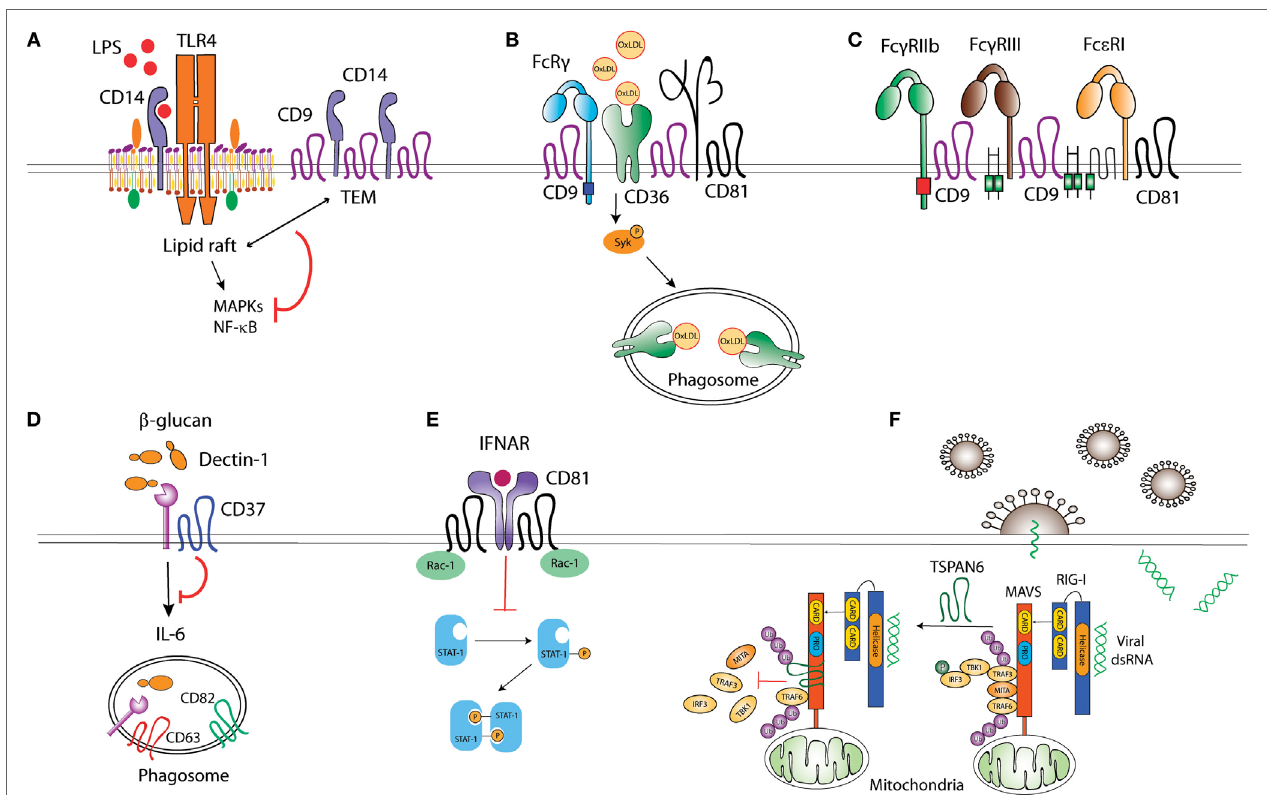
FigURe 1 | Tetraspanins act as molecular organizers of pattern recognition receptors (PRRs). (A) CD9 sequesters TLR4 co-receptor CD14 into tetraspanin- enriched microdomains (TEMs), impairing its localization into lipid rafts, and thus preventing TLR4 downstream signaling. (B) CD36 coupling to the adaptor FcR γ is mediated by the complex formed between CD36, β 1, and/or β 2 integrins, and CD9 and/or CD81 tetraspanins. CD36 association with tetraspanins regulates its engagement with Src and Syk kinases, and its internalization when bound to ligands like oxidized low-density lipoproteins. (C) CD9 collaborates with Fc γ RIIb and Fc γ RIII upon macrophage activation, and, together with CD81, associates with Fc 𝜀 RI. (D) CD37 stabilizes membrane C-type lectin receptor Dectin-1 and inhibits IL-6 production. (e) CD81 interaction with Rac-1 prevents STAT-1 activation downstream of interferon- α / β receptor (IFNAR) stimulation. (F) The interaction between ubiquitinated Tspan6 and MAVS (mitochondrial antiviral signaling) interferes with RIG-I (retinoic acid-inducible gene I)-induced recruitment of downstream molecules TRAF3, MITA, and IRF3 to MAVS after viral RNA